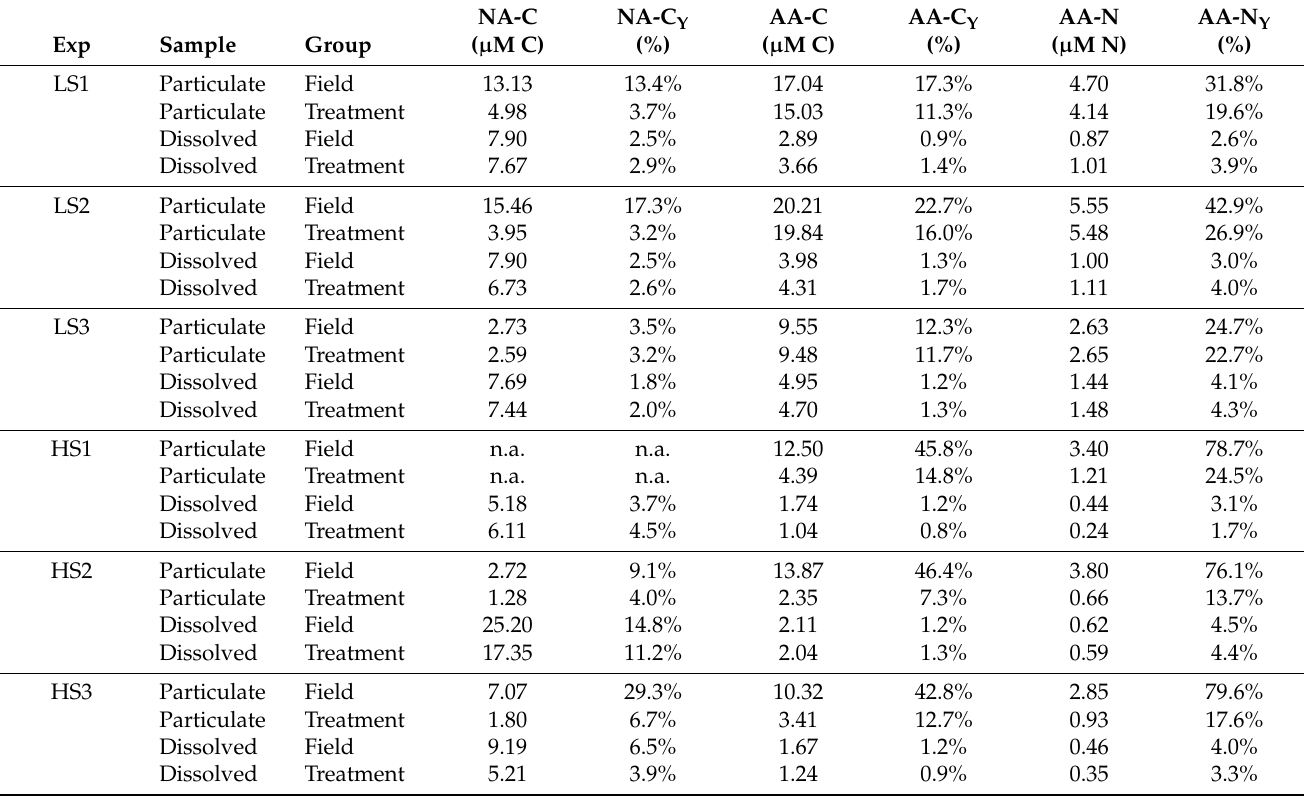
The carbon yields (C-yields) from PHNA had a wide range in the study, showing a range of 3.5 to 17.3% and 3.7 to 29.3% in low- and high-salinity samples, respectively (Table 5). The C-yields from DHNA were lower than those from PHNA. The DHNA C- yields ranged from 1.8 to 2.5% in low-salinity samples, while those in high-salinity samples were higher and in a wider range (3.7 to 9.1%). In low-salinity samples, the carbon and nitrogen yields (N-yields) from PHAA were 12.3 to 22.7% and 24.7 to 42.9%, respectively (Table 5). In high-salinity samples, the PHAA C- and N-yields (42.8 to 46.4% of POC and 76.1 to 79.6% of PON) were higher than those in low-salinity samples. In general, the C- and N-yields from DHAA (0.9 to 1.2% of DOC and 2.6 to 4.5% of TDN) were lower than those from PHAA (Table 5). Table 5. C- and N-yields in hydrolysable neutral aldose (NA) and hydrolysable amino acid (AA) fractions. C Y and N Y denote C- and N-yields, respectively. LS and HS denote low- and high-salinity samples, respectively.